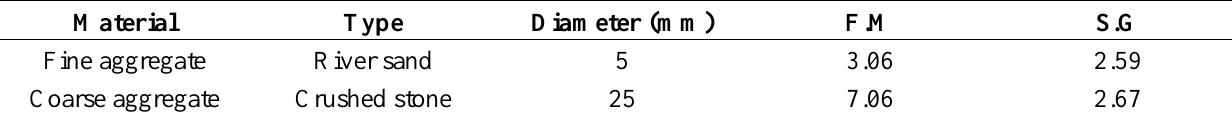
Table 3. Properties of the aggregate.